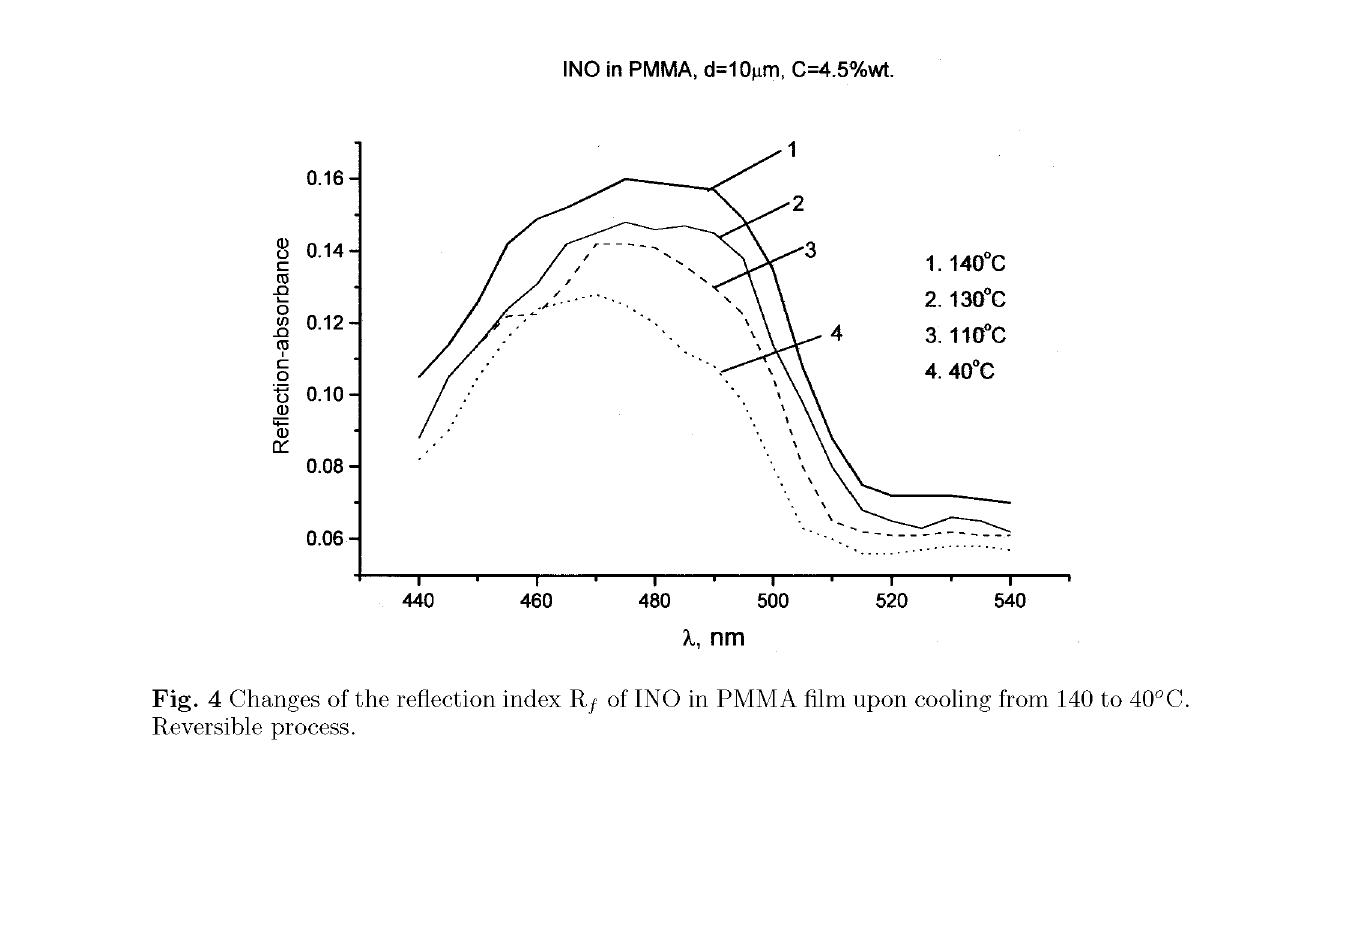
Fig. 4 Changes of the reflection index Rf of INO in PMMA film upon cooling from 140 to 40~ Reversible